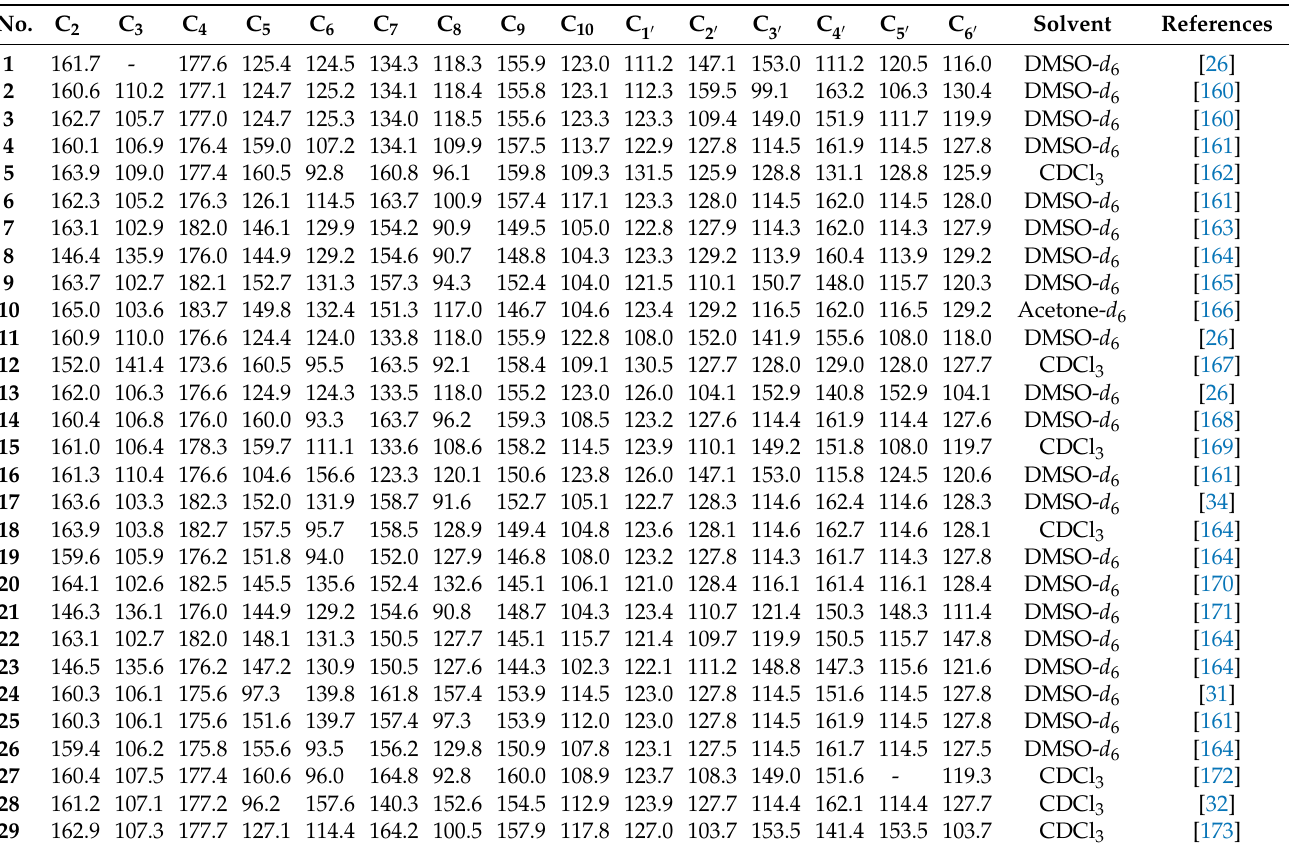
Table 10. 13 C-NMR of polymethoxyflavones’ ( 1 – 71 ) skeleton isolated in Citrus